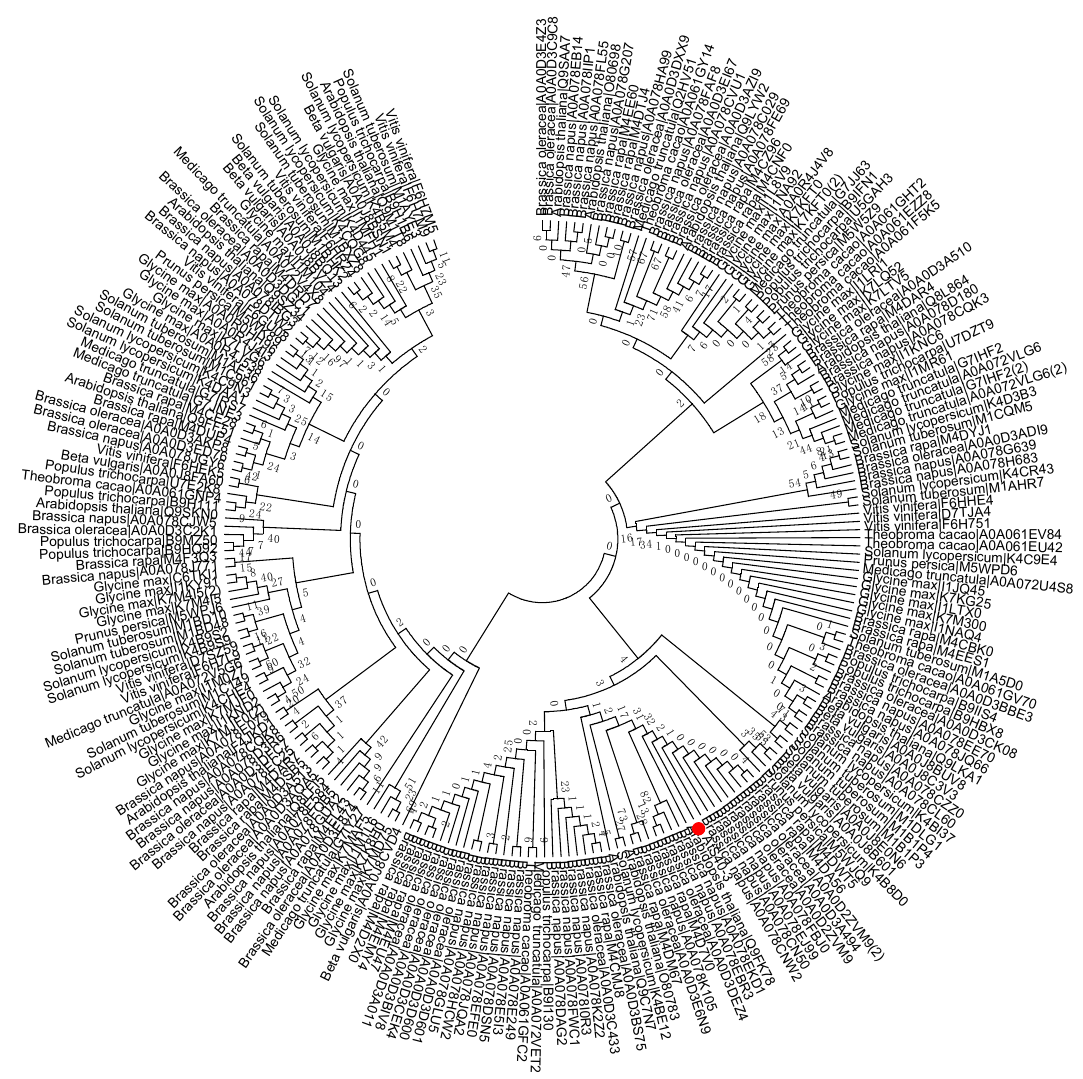
Figure 2. Phylogenetic tree of the S40 gene family in sequenced genome dicot plants including Arabidopsis thaliana, Beta vulgaris, Brassica napus, Brassica oleracea, Brassica rapa, Glycine max, Medicago truncatula, Populus trichocarpa, Prunus persica, Solanum lycopersicum, Solanum tuberosum, Theobroma cacao, and Vitis vinifera. Red dot indicates the S40 senescence reference gene, AtS40-3 . The MEGA 6.0 program was employed to construct a neighbor-joining phylogenetic tree using the JTT model with 1000 bootstrap replicates. The full-length amino acid sequences were aligned using Clustal Omega.